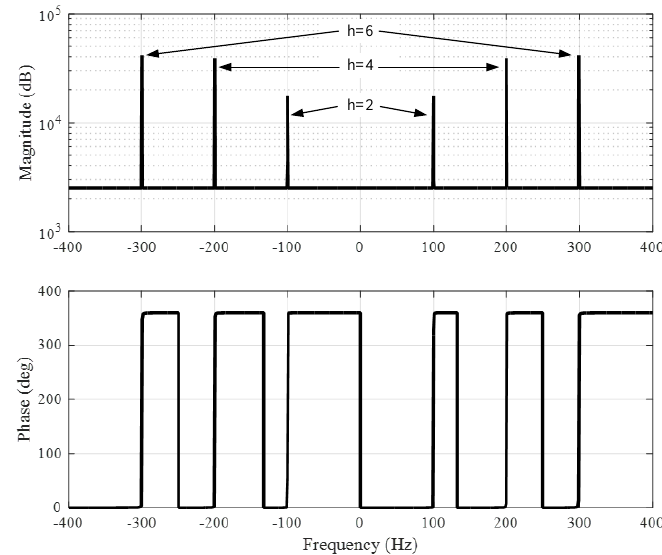
Figure 11. Resonant controllers scheme Bode diagram.